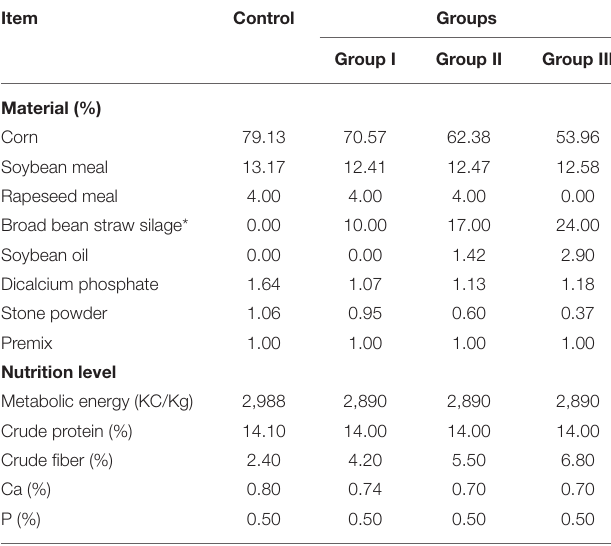
TABLE 1 | Ingredient composition and the nutrient and energy content of the diet. Item Control